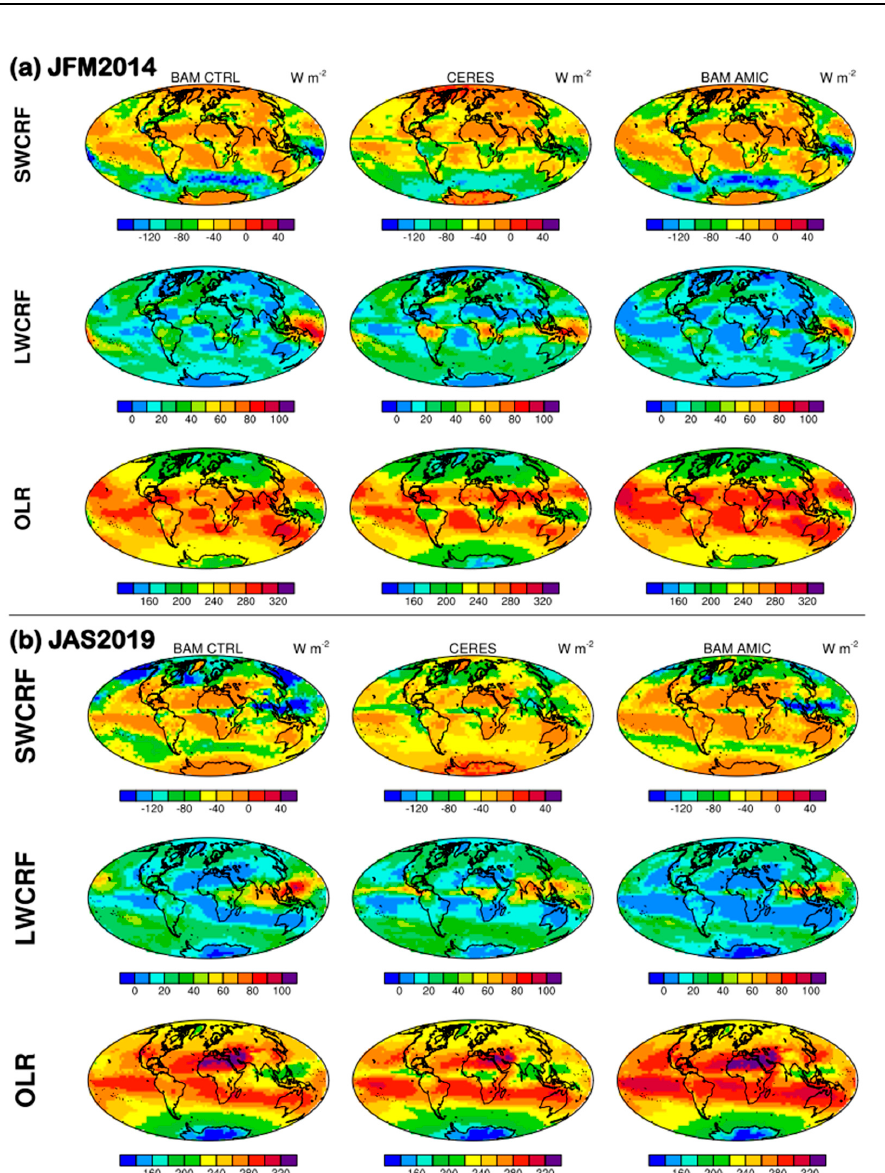
Figure 4. Model evaluation of cloud radiative properties for ( a ) JFM2014 and ( b ) JAS2019. Simulated means from BAM CTRL (left column) and BAM AMIC (right column) are compared with CERES satellite observations (middle column) corresponding to a similar period. Variables evaluated include shortwave cloud radiative forcing (SWCRF), longwave cloud radiative forcing (LWCRF), and outgoing longwave radiation (OLR). Table 3. Model performance statistics of cloud properties and precipitation for JFM2014 set of ex- periments. BAM CTRL